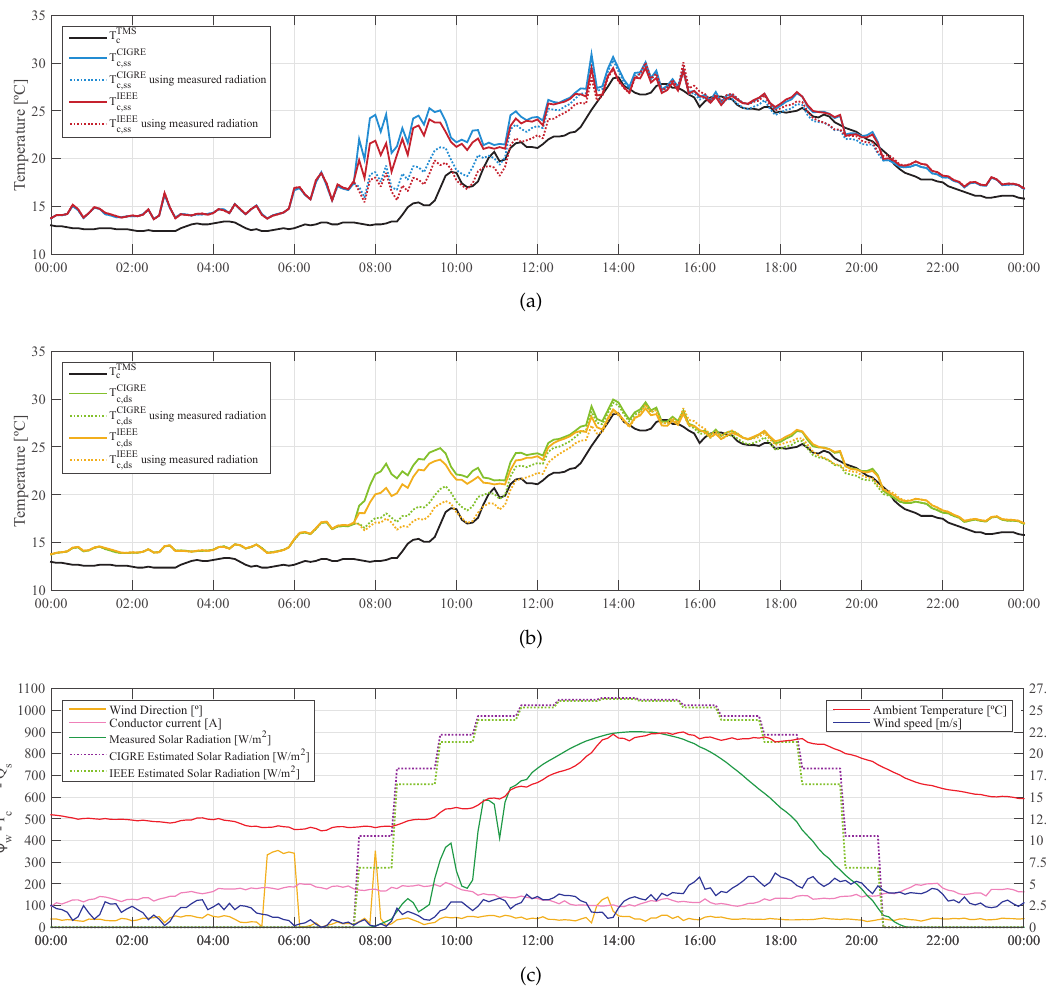
Figure 4. Comparison of conductor temperature obtained using IEEE ( T IEEE c , ss and T IEEE ( T CIGRE c , ss and T CIGRE ) standards with the measured conductor temperature ( T TMS c ) for a single day. c , ds ( a ) Steady state balance (30 August 2014); ( b ) Dynamic state balance (30 August 2014); ( c ) Weather conditions (30 August